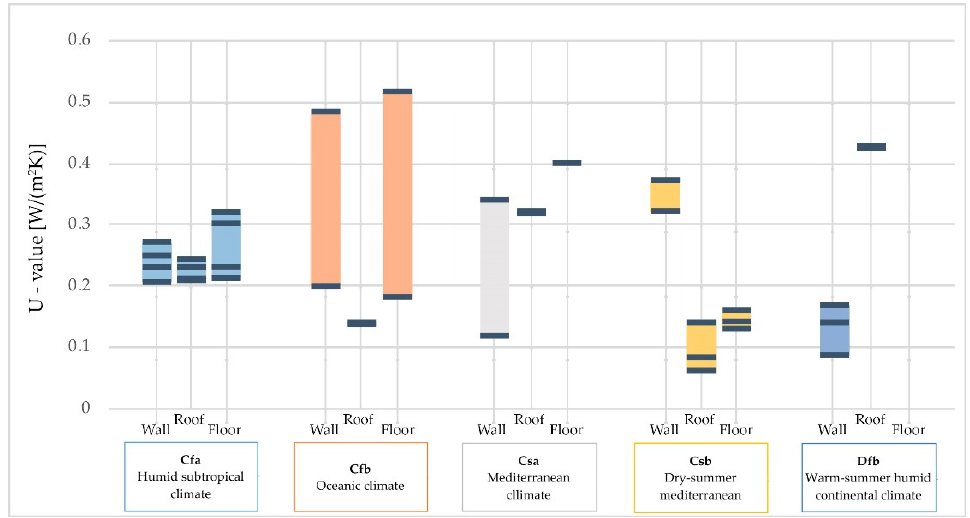
Figure 23. Optimal EEMs for opaque envelope—single-family buildings. Energies 2018 , 11 , x FOR PEER REVIEW